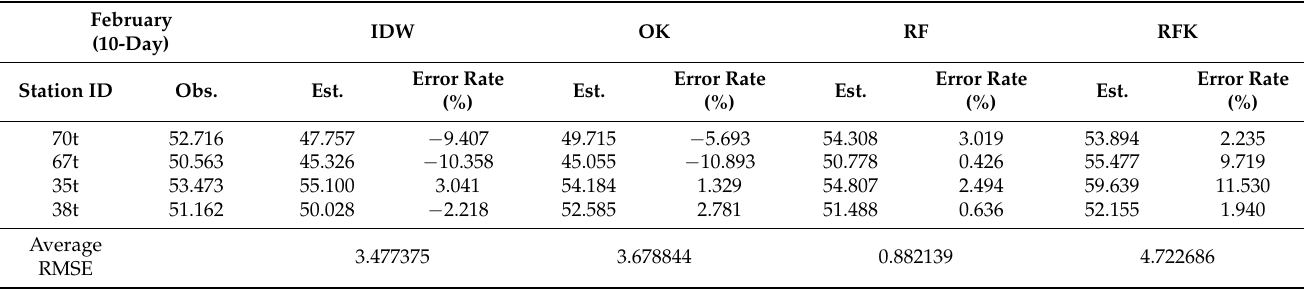
Table 6. Test station-based comparison between observations and estimates from interpolation models with observed concentration over 50 µ g/m 3 from a 10-day dataset in